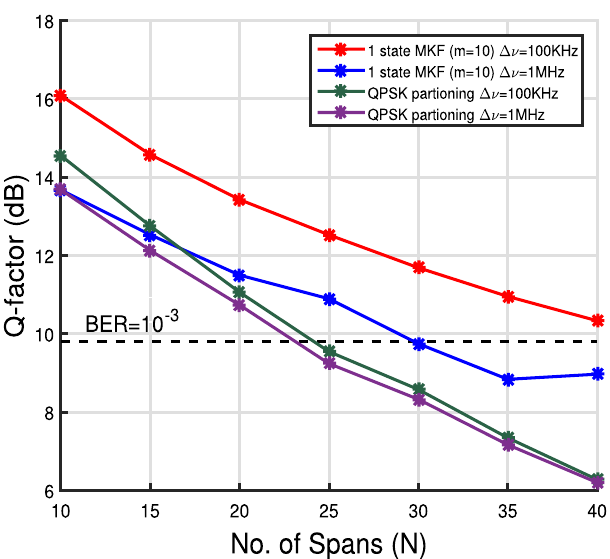
100 kHz and launch power of 1 dBm. = 3 is